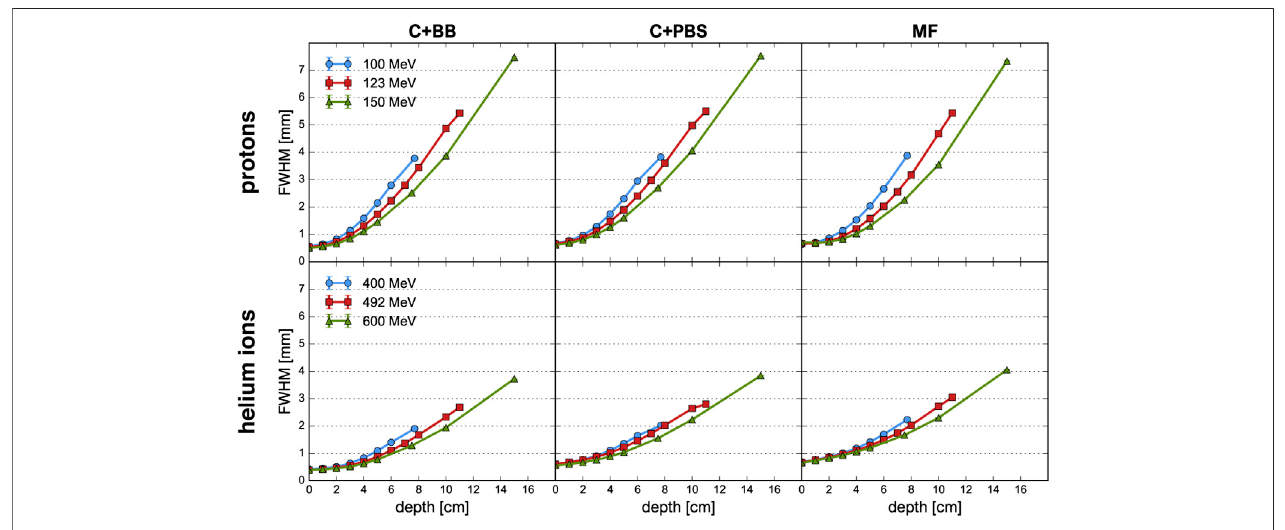
FIGURE 3 | Evolution of the FWHM as a function of depth for proton beams (top row) and helium ion beams (bottom row) and for the different minibeam techniques (columns). The uncertainty bars are smaller than the markers.